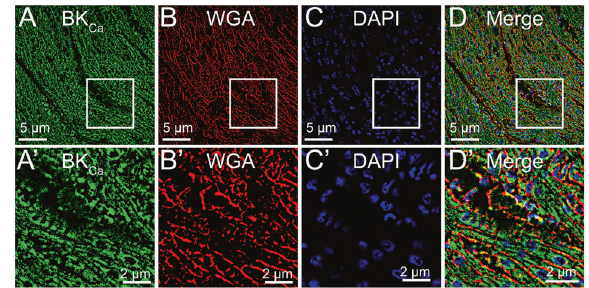
Fig. 8 Plasma membrane localization of BK Ca channel in human infant hearts. Human infant heart sections were fi xed and labeled with A BK Ca (green), B WGA (red), and C Nuclei (blue). The bottom panels A ’– D ’ are shown at higher magni fi cation with colocalization of BK Ca to WGA in D and D ’